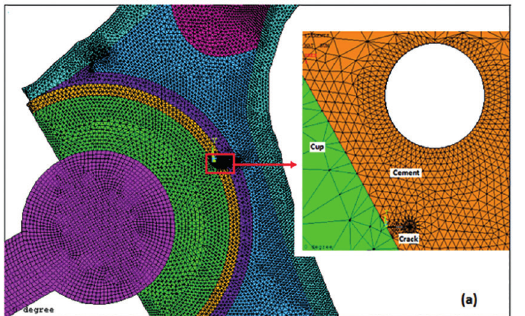
Figure 12: Typical mesh model near the cavity and the crack.